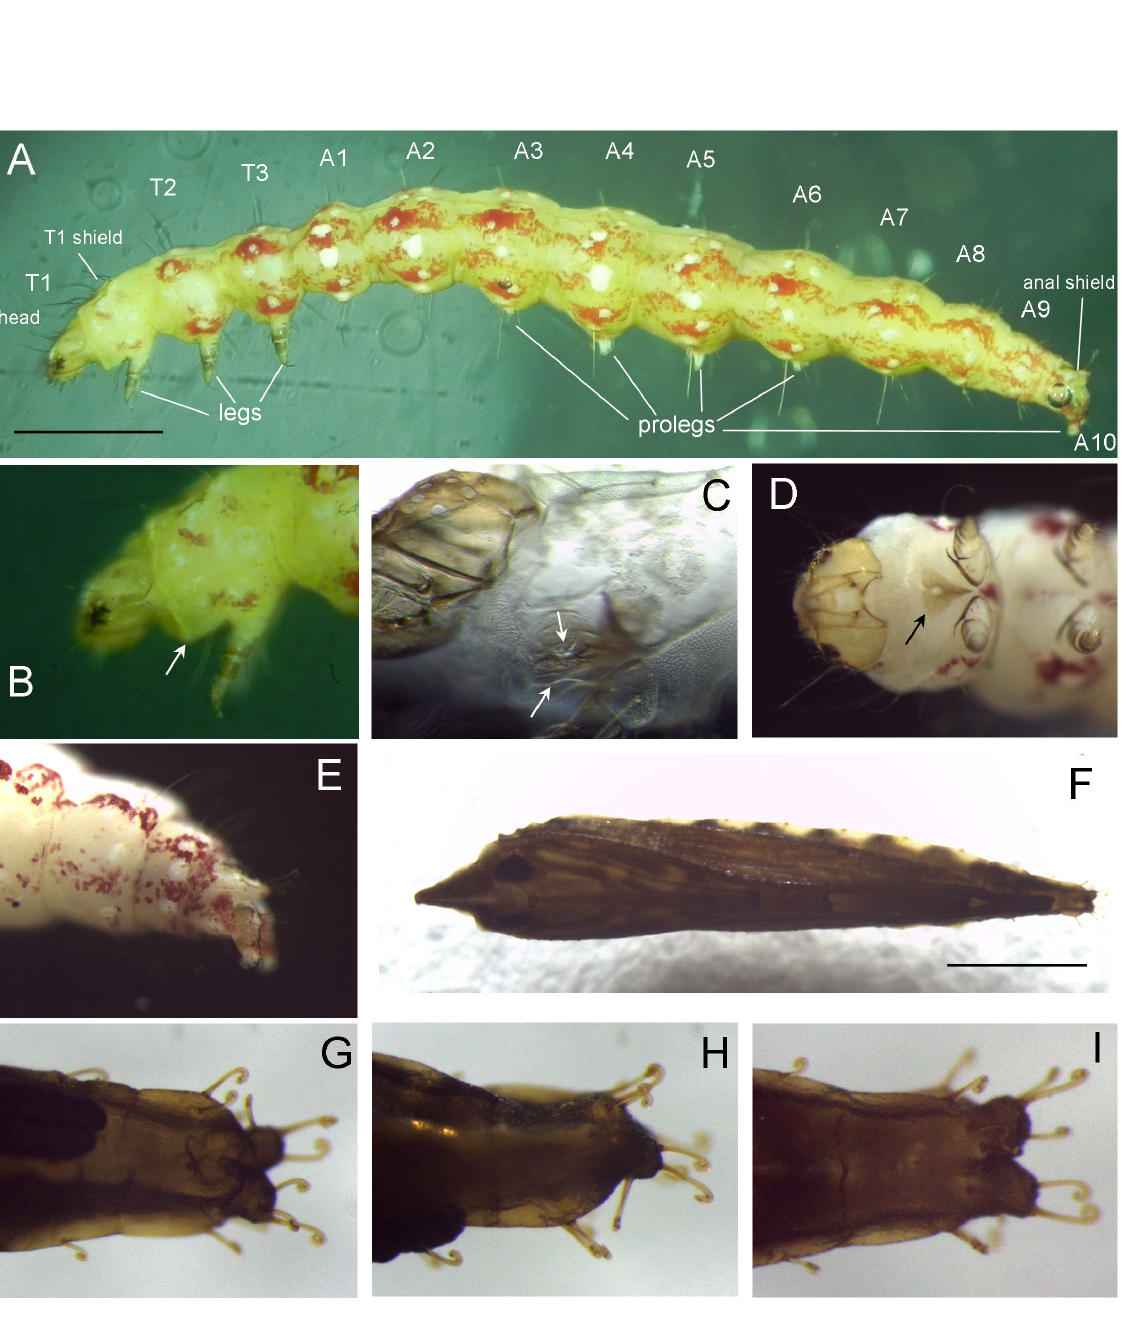
Fig. 16. Mature larva and pupa of Bedellia somnulentella Zeller, 1847. A–E. Mature larva (OPU-IN- LE2018IV0031|SK612, 0032|SK613). F–I. Pupa (OPU-IN-LE2018IV0038–0039). A . General, lateral view. B . Head and thorax, lateral view. C . Jugular gland-like structure, lateral view. D . Head and thorax, ventral view. E . A8–A10, lateral view. F . General, ventral view. G . Setae of A8–A10, ventral view. H . Lateral view. I . Dorsal view. Scale bars: 1